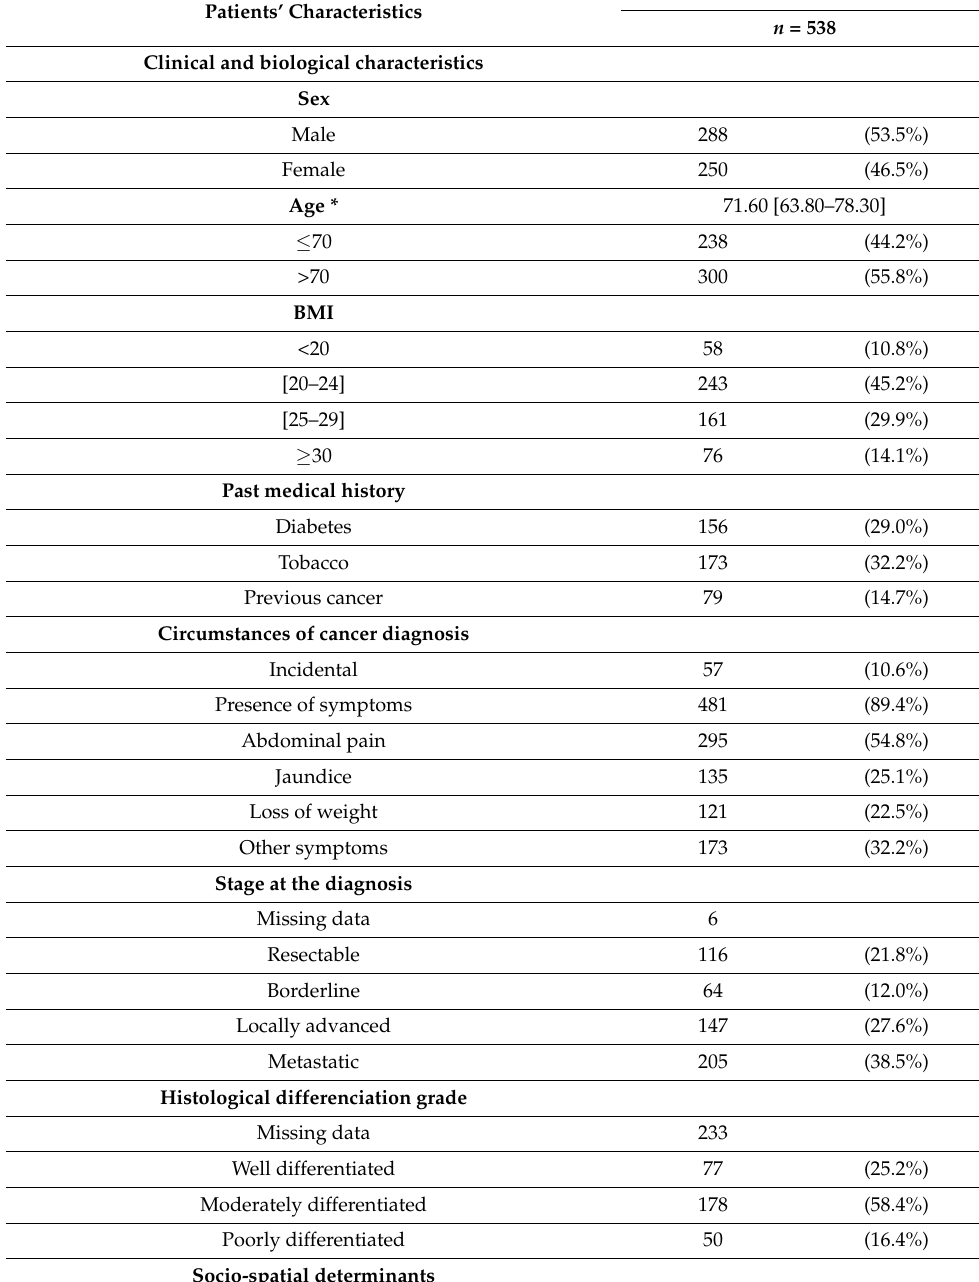
Table 1. Patient and treatment